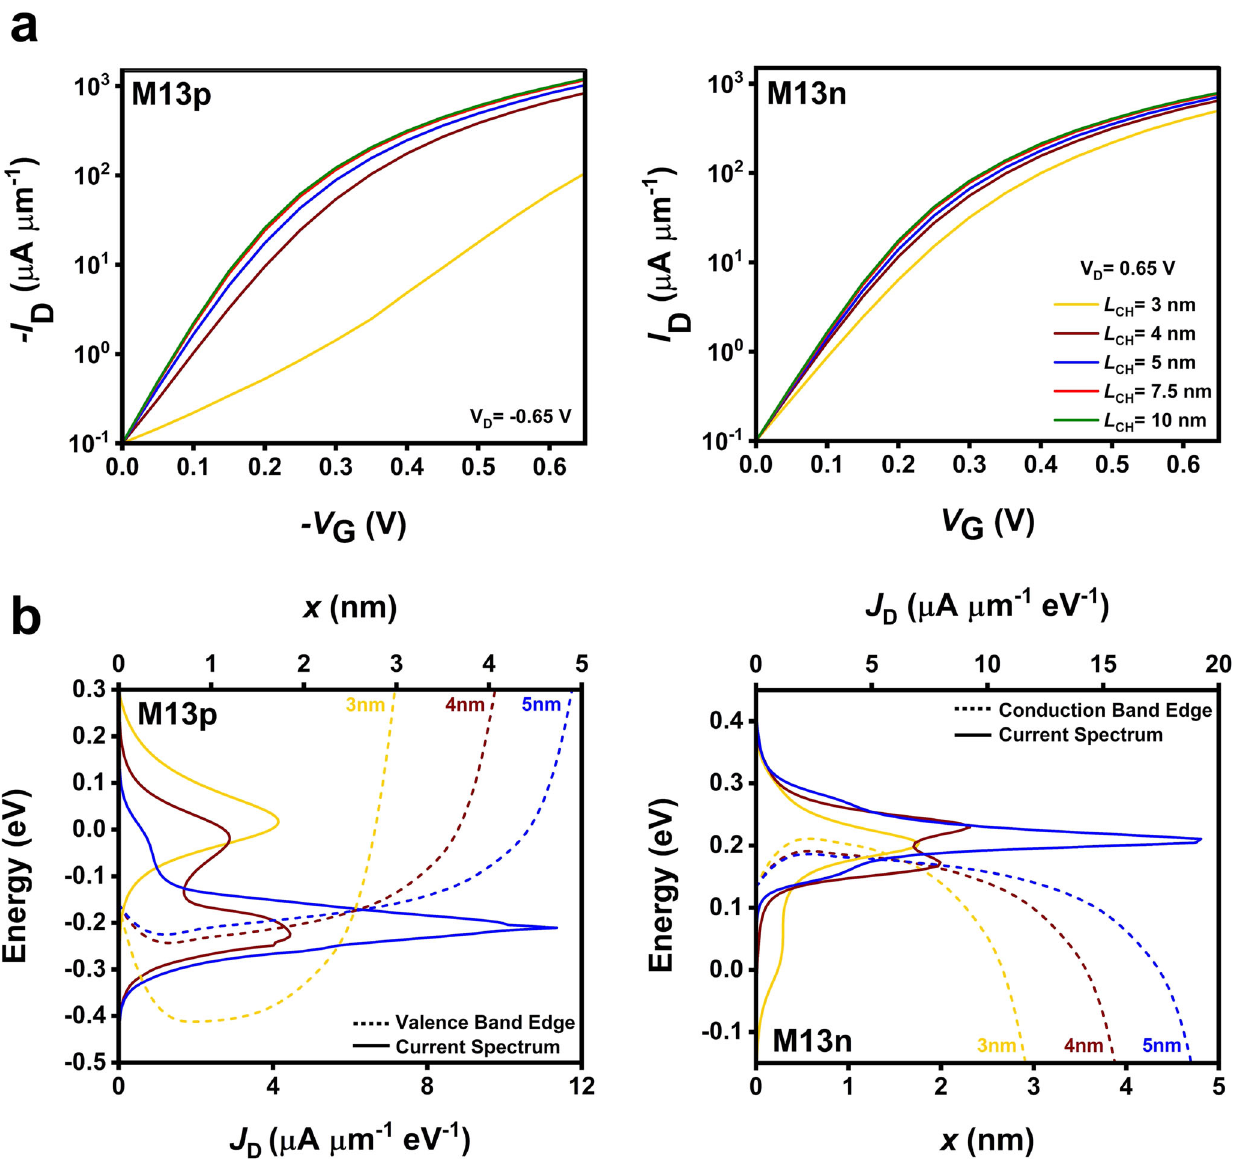
Fig. 5 Device characteristics of M13p and M13n. a Transfer characteristics of transistors at a drain bias of |V D | = 0.65 V for L CH = 10 nm to 3 nm. b Energy resolved current spectrum ( J D ) superimposed on valence (conduction) band edge pro fi le of transistor M13p (M13n) at OFF state for L CH = 5 nm to 3